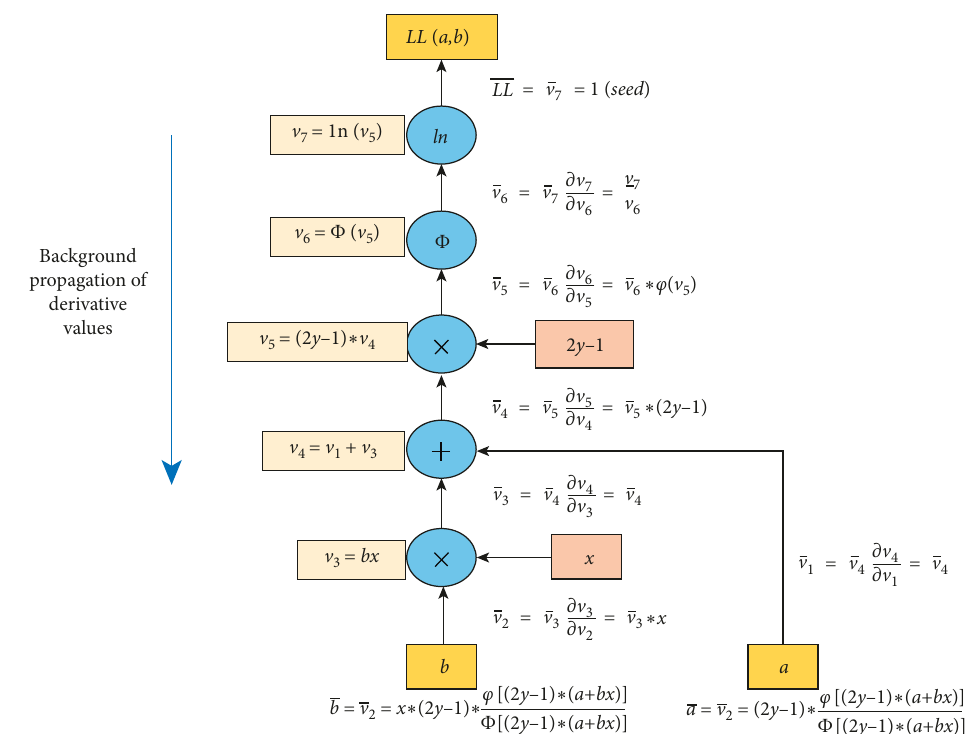
Figure 2: Example of reverse-mode AD in the computation